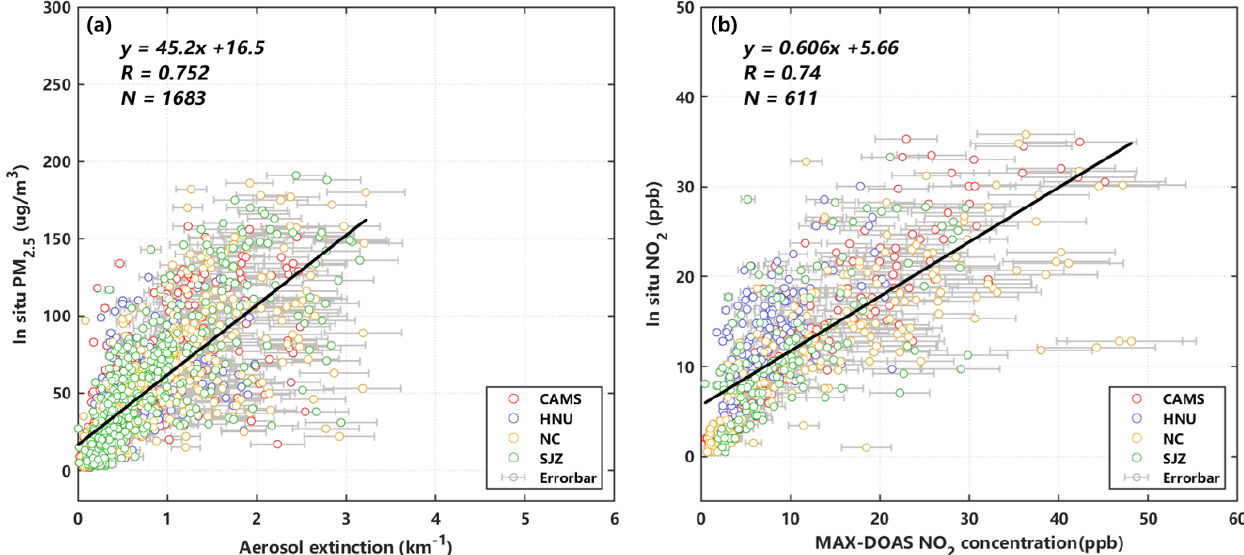
Figure 2. (a) Correlation analysis of in-situ-measured PM 2 . 5 and surface AECs (0–100m) retrieved from CAMS, HNU, NC, and SJZ MAX-DOAS stations from January to March 2021 and (b) their corresponding NO 2 comparative results. The black line denotes the linear least-squares fit to the data; R denotes Pearson correlation coefficient; N denotes the number of valid